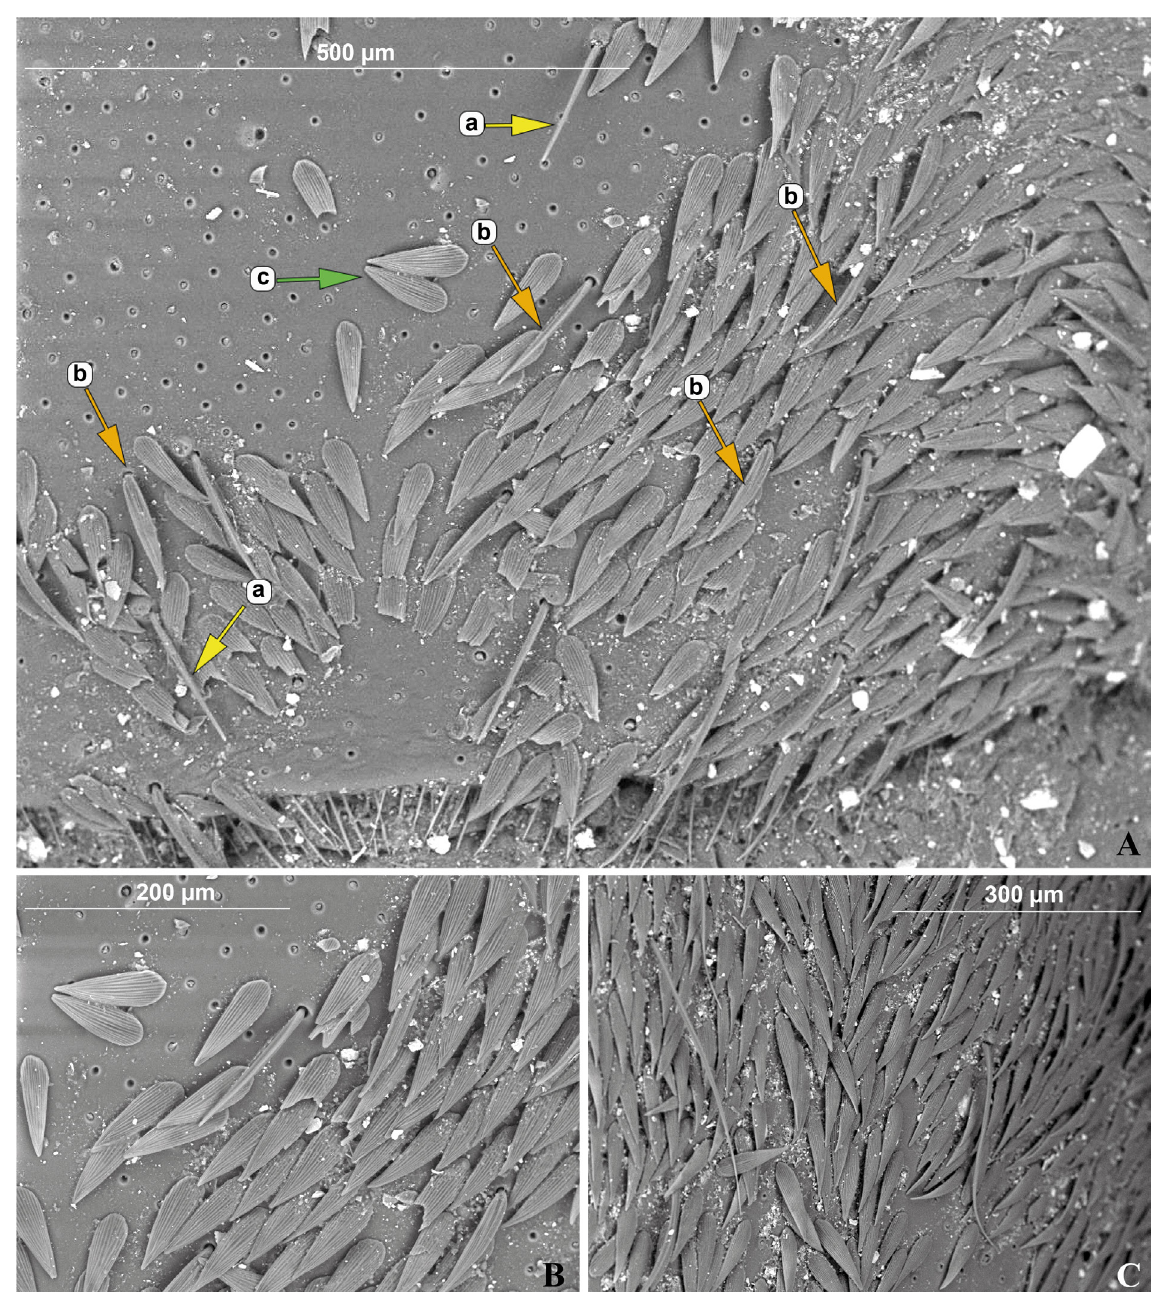
Fig. 10. Habrochiton vernus Semenov-Tjan-Shansky, 1907, ♀, paralectotype (ZIN), covers and setation. A . Covers of pronotum. B . Ditto, larger scale. C. Elytral covers. a = simple setae; b = scale-like setae; c =